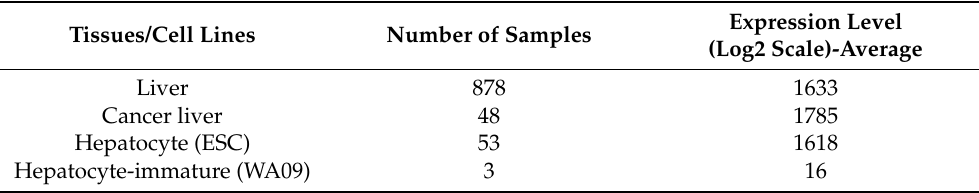
Table 1. Expression analyses performed by Genevisible (http://genevisible.com, assessed on 18 September 2021) showing the comparison between GLUD1 gene expression in normal and cancer liver. Hepatocyte (ESC): Hepatocytes derived from embryonic stem cells. Hepatocyte-immature (WA09): generation of hepatocyte-like cells from human embryonic stem cell line WA09. Tissues/Cell Lines